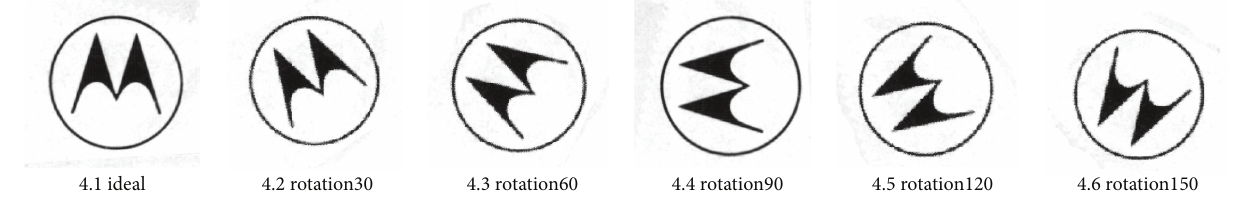
Figure 4: Logos with rotation.